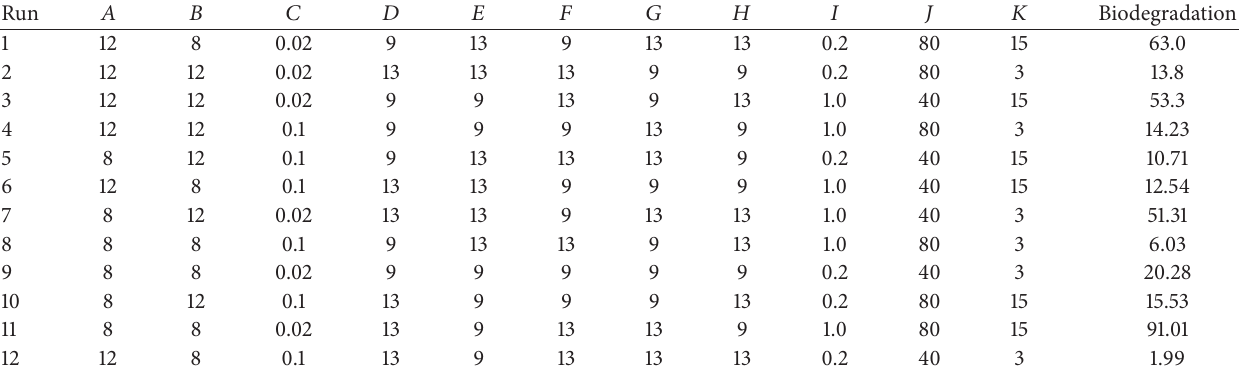
Table 5: Plackett-Burman experimental design for evaluating factors influencing dye degradation by M. cladophyllus UMAS MS8.